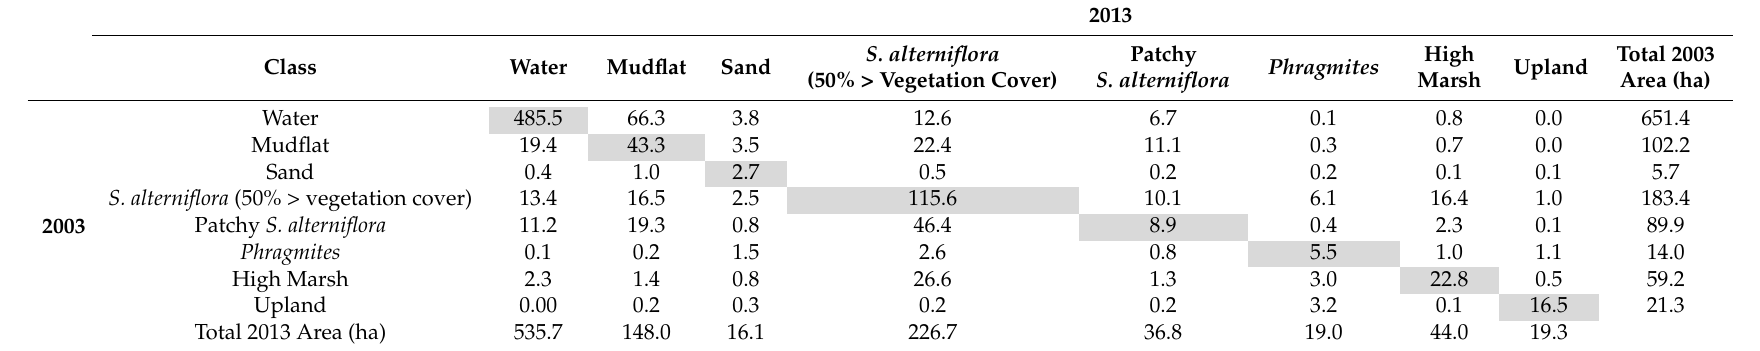
Table 3. Change between 2003 and 2013 (ha). Areas that had no change between the two dates are in